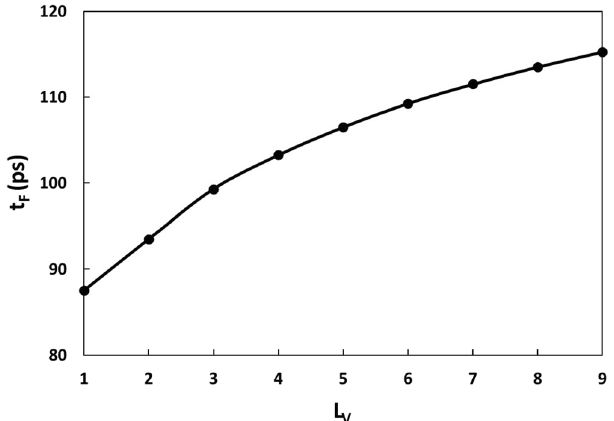
Figure 5. Variation of failure start time with the B vacancy position. L v is the number of the h-BN layer counting from the top layer with a B vacancy.